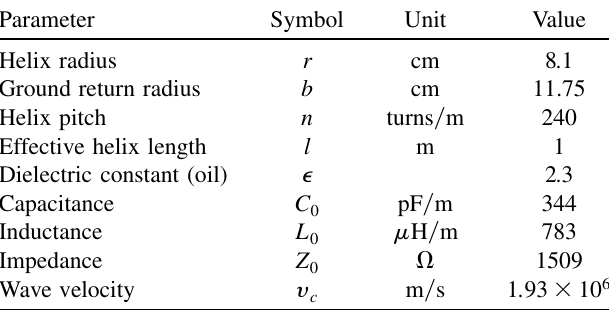
Figure 1(b) is a simple applied voltage profile on the helix coil. Figure 1(c) shows the helical structure for this